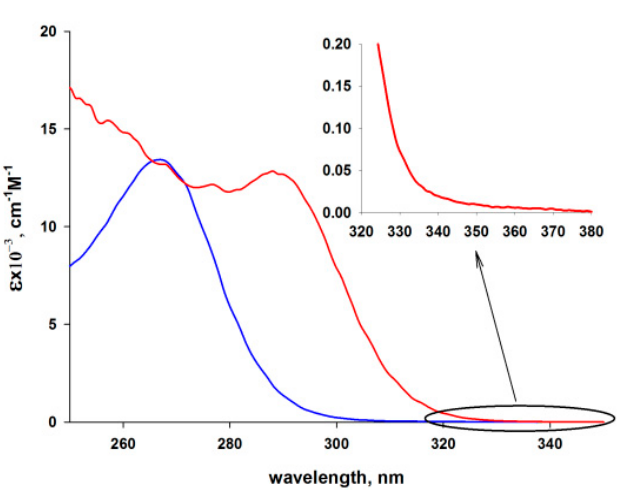
Figure 8. Absorption spectra of complexes 1 (blue) and 2a (red) in CH 2 Cl 2 solution.